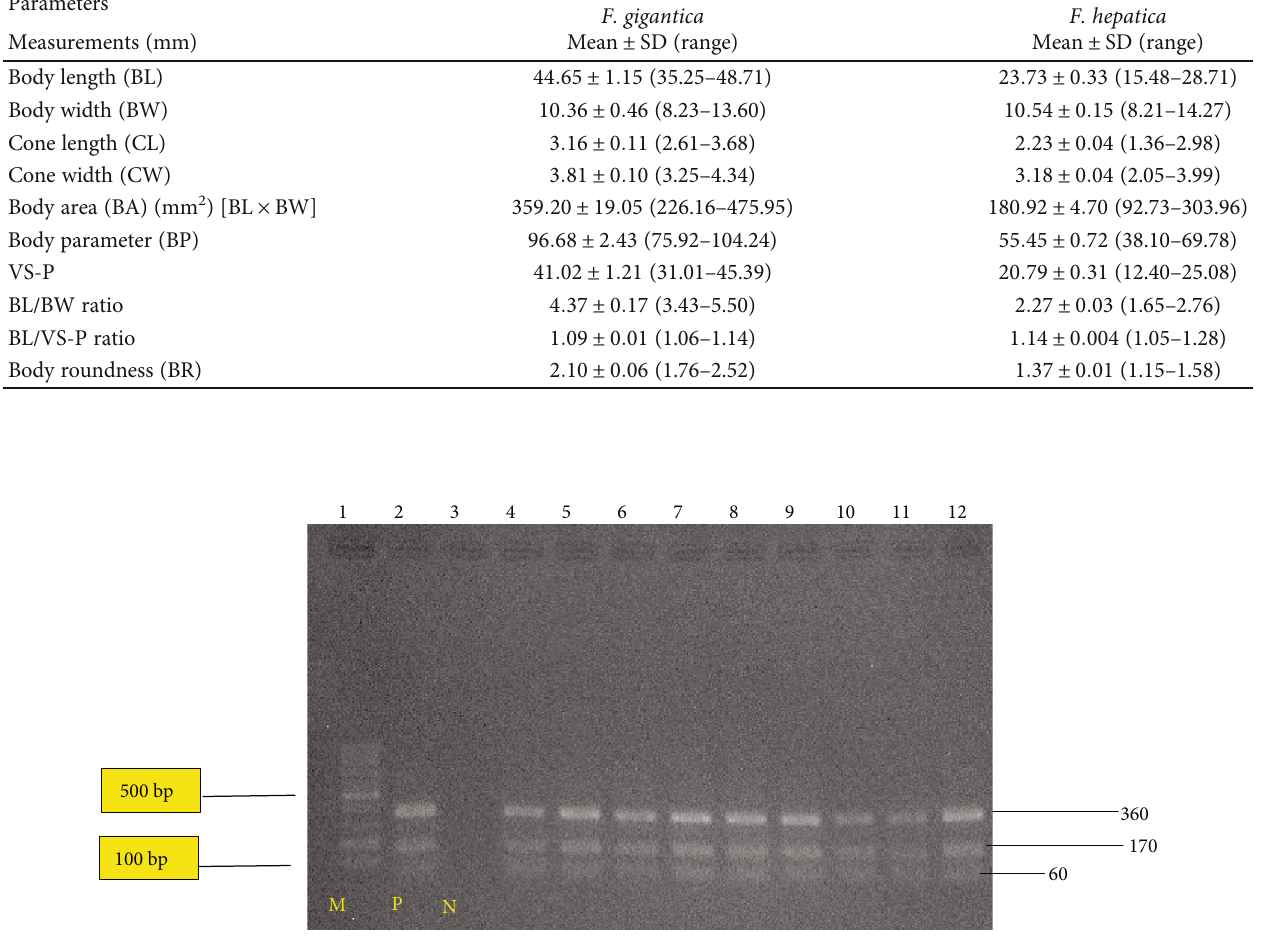
Table 3: Comparison of morphometric data between Fasciola hepatica and Fasciola gigantica present in bovines from Egypt [15]. Parameters